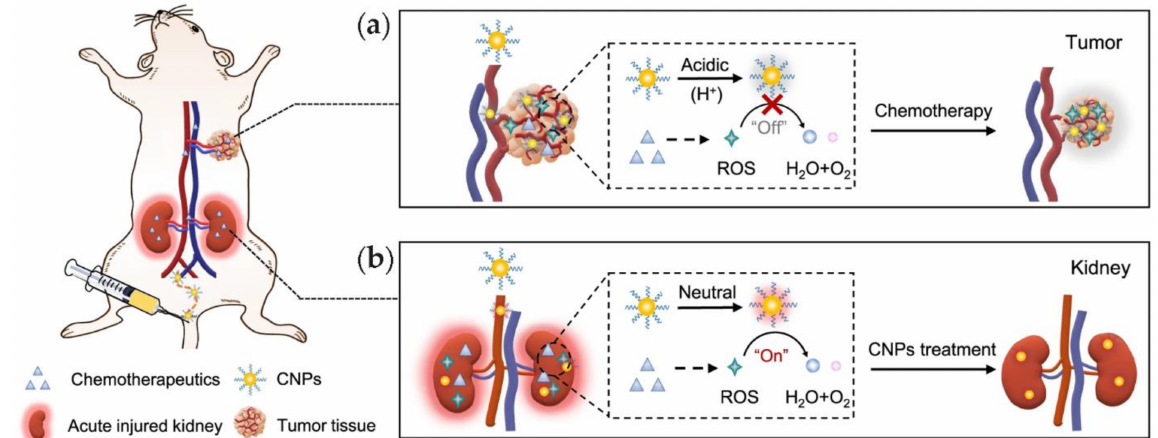
Figure 11. Schematic representation of pH-dependent redox activity of ceria NP as tested in vivo. ( a ) In the acidic tumor microenvironment, ceria NPs ROS scavenging ability is switched off and does not interfere with oxidizing chemotherapeutics; ( b ) in the neutral pH of the kidneys, ceria NPs scavenge ROS and exert cytoprotection. Reproduced from [119], under